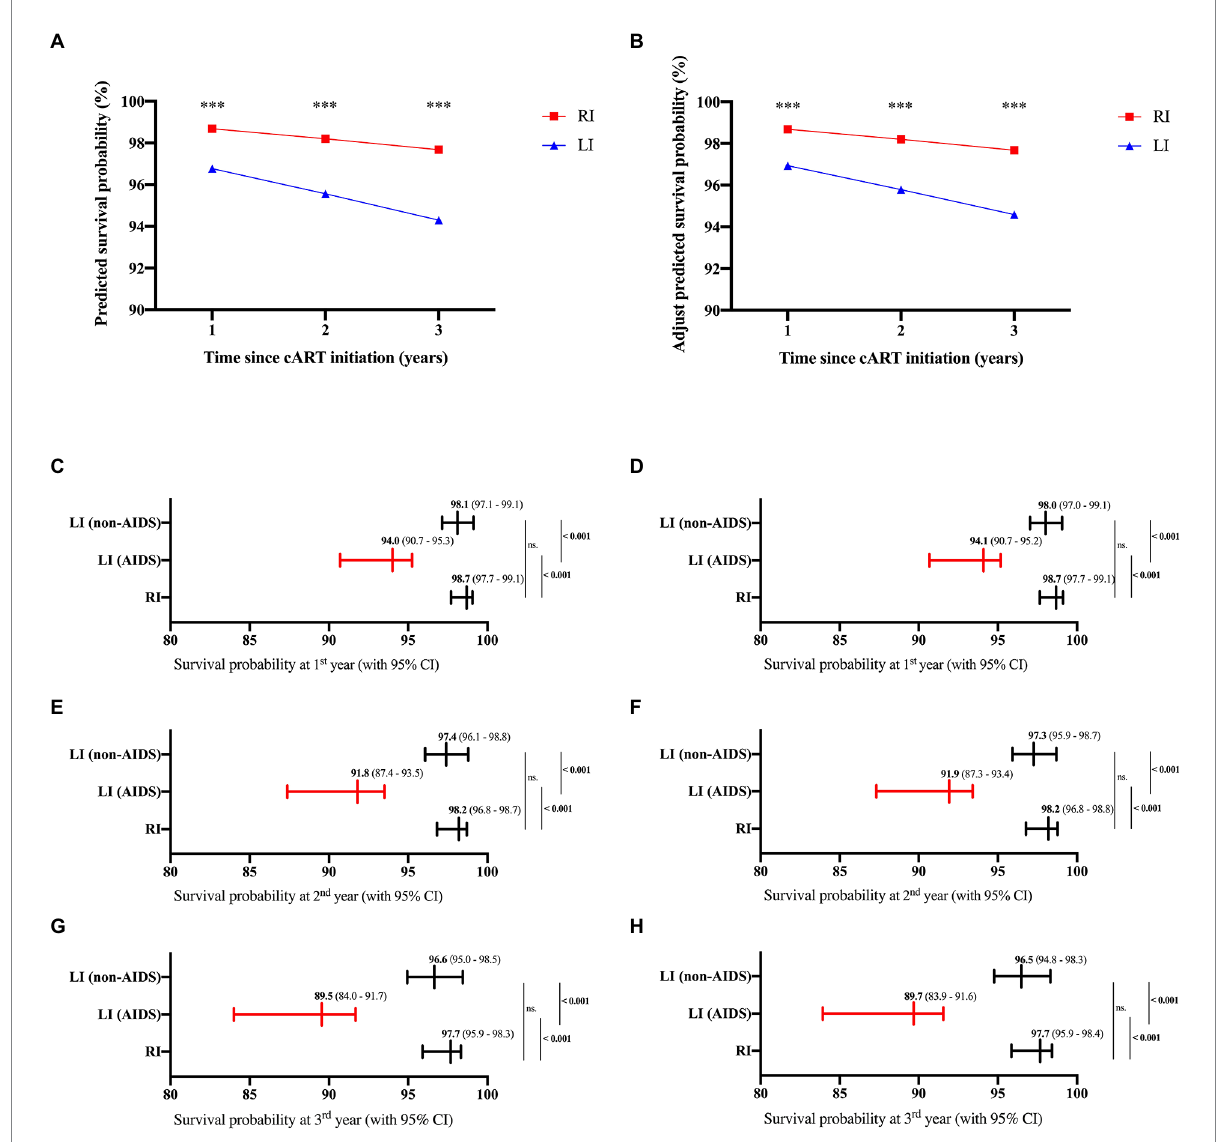
FIGURE 5 Predicted survival probabilities of cART-treated HIV-1 patients. The survival probabilities were predicted based on Wenzhou model (left) and adjusted for age and gender (right) according to the previous studies (Hou et al., 2019; Wang et al., 2020) for HIV-1 patients of recent and long- term infection at 1st, 2nd and 3rd year after cART (A,B) , or for HIV-1 patients of recent and long-term infection with or without AIDS at 1st (C,D) , 2nd (E,F) , and 3rd (G,H) year after